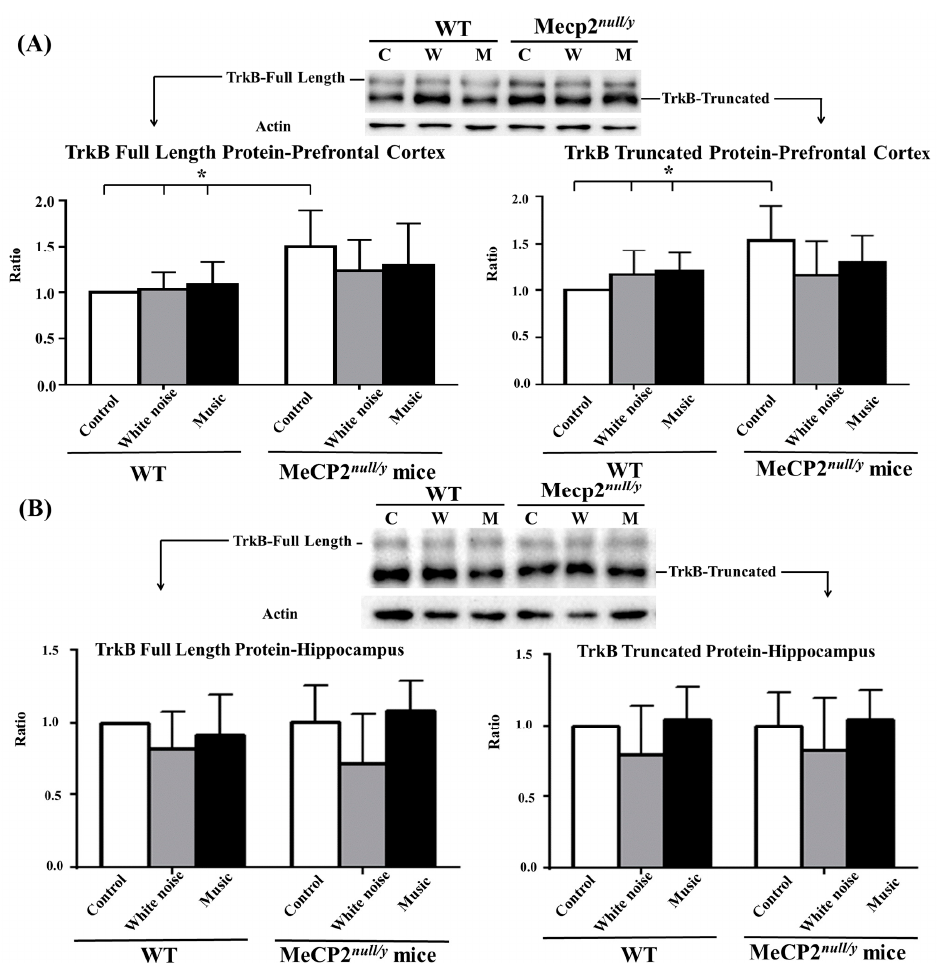
Figure 5. Analysis of full length and truncated TrkB proteins in wild-type and mecp2 null/y mice in the PFC and hippocampus. Mecp2 null/y mice that did not undergo a music-based intervention produced significantly higher full length and truncated TrkB protein levels in the prefrontal cortex ( A ) but not in the hippocampus ( B ) as compared with all wild-type mice and mecp2 null/y mice that underwent a music-based intervention (* p < 0.05).